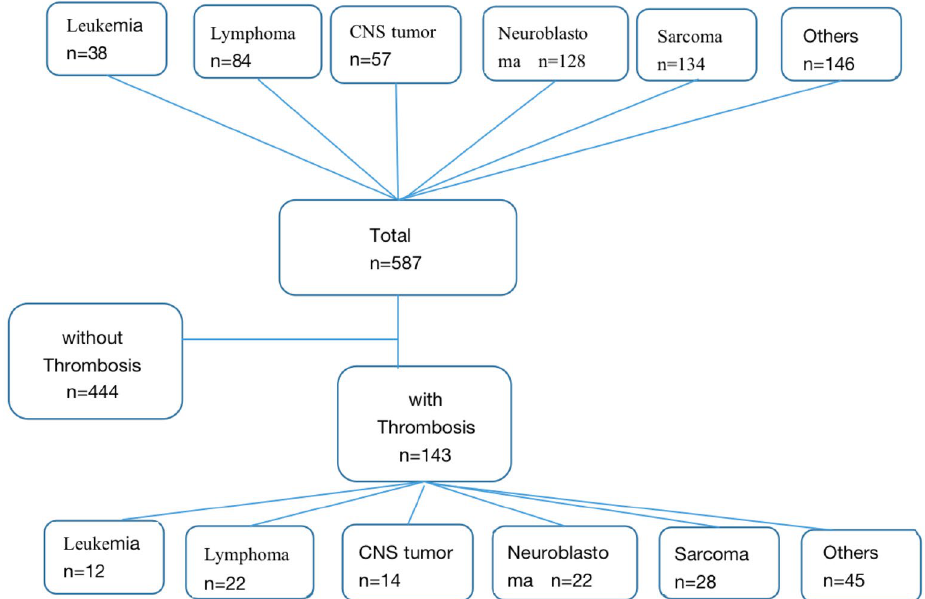
Figure 1. Flow chart of study populations.